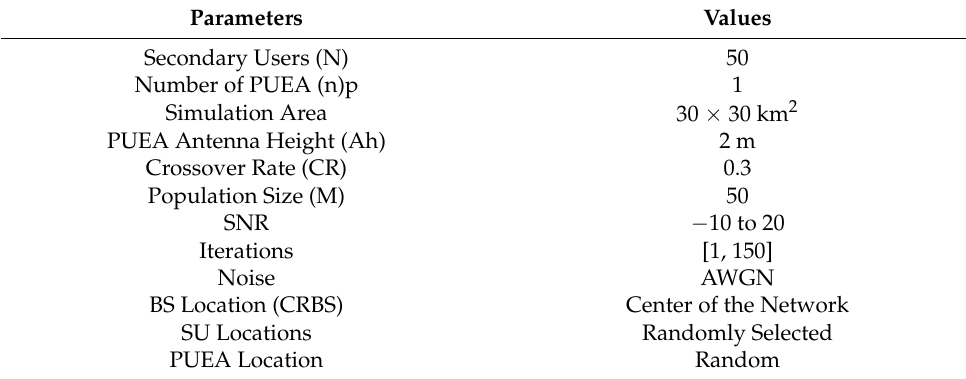
Figure 3. Deployment of SUs in a CRN with area of 30 km × 30 km. Table 1. Simulation parameters and values.